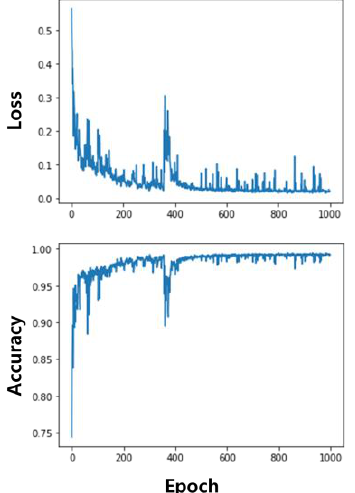
Figure 4. Loss and accuracy for iteration